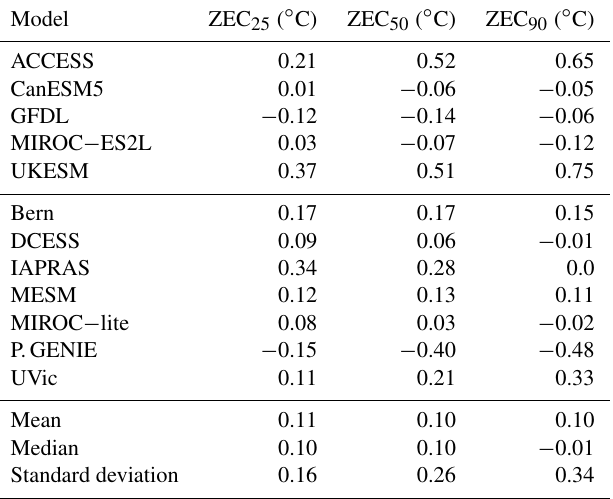
Table C2. Temperature anomaly relative to the year that emissions ceased averaged over a 20-year time window centred on the 25th, 50th, and 90th year following the cessation of anthropogenic CO 2 emissions (ZEC 25 , ZEC 50 , and ZEC 90 , respectively) for the A3 (2000PgC 1%)